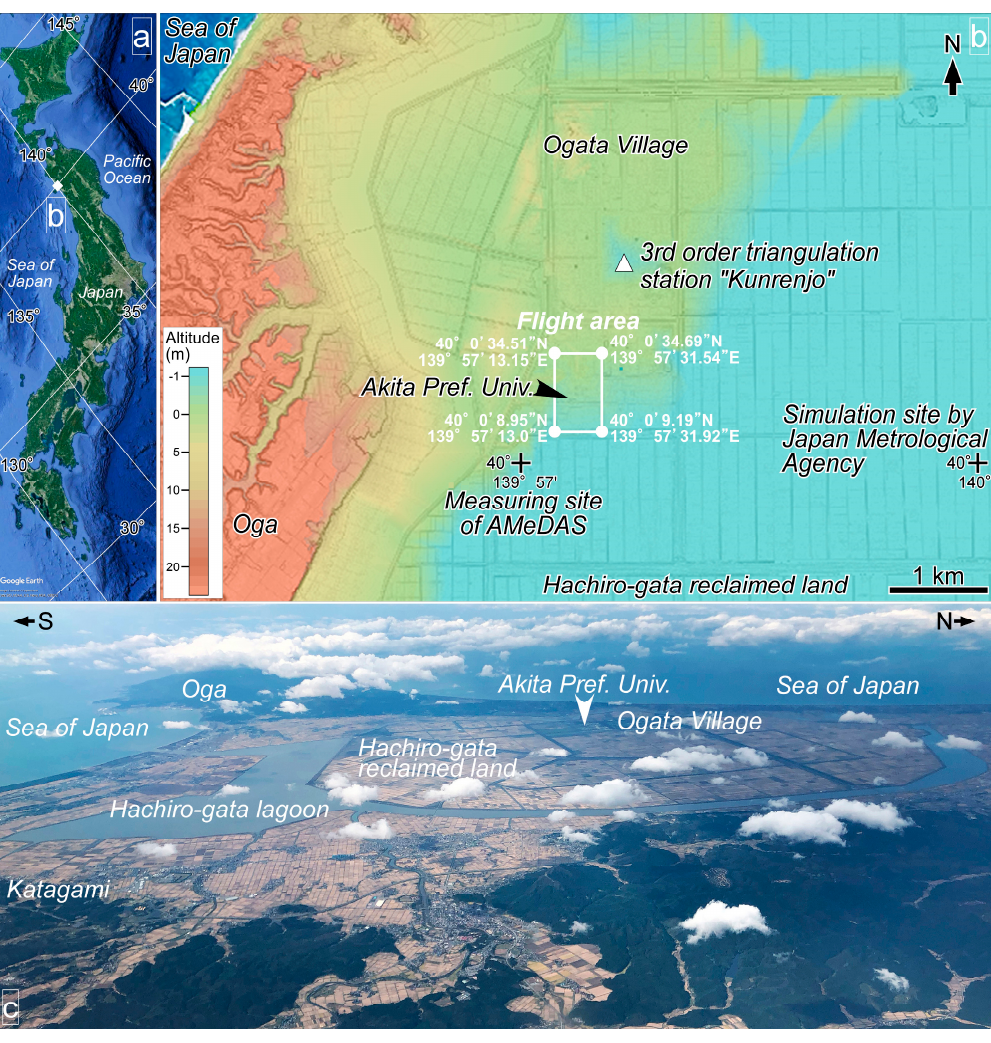
Figure 1. Map showing ( a ) location of Akita Prefecture, Japan and ( b ) the observation area in Ogata Village*. ( c ) Photograph of bird’s-eye view around Ogata Village area taken in October 2018. (*) The map based on the aerial photograph, elevation chart map by color and slope gradation map created by Geospatial Information Authority of Japan [35].